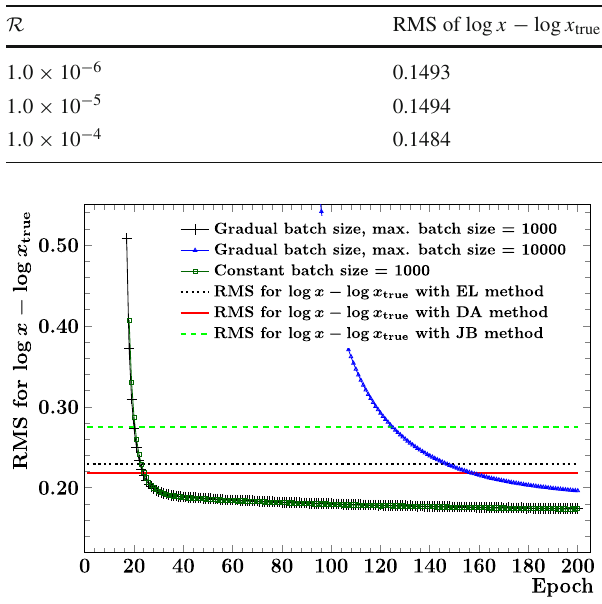
Fig. 4 Training history for x reconstruction model using different training parameters but the same Q 2 reconstruction model obtained with L = 1 . 0 × 10 − 5 , R = 1 . 0 × 10 − 6 and B = 10 , 000. In each of the cases, the initial learning rate was set to L = 1 . 0 × 10 − 5 and the regularisation parameter to R = 1 . 0 × 10 −